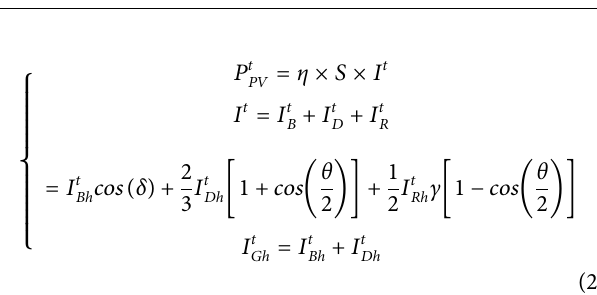
FIGURE 2 | Optimal power